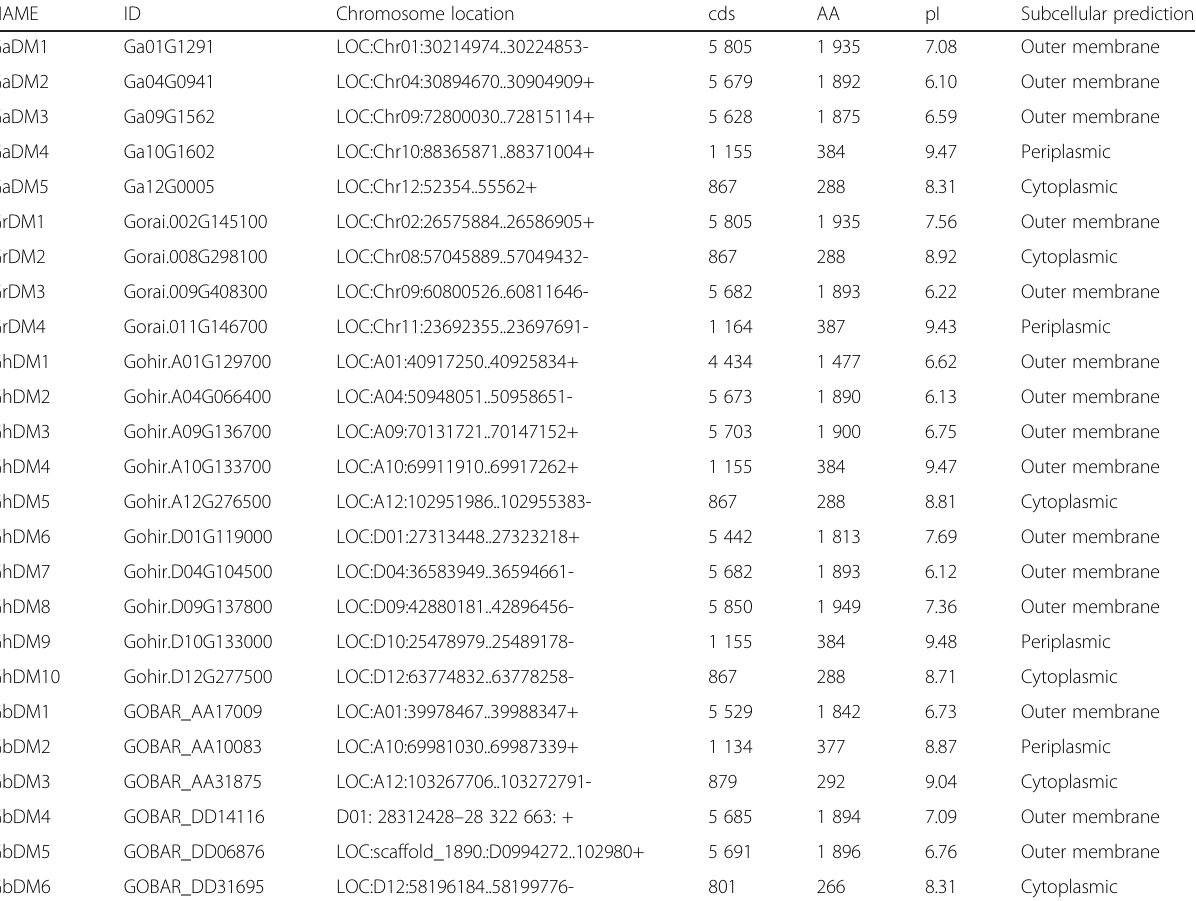
Table 1 Basic characteristic of DNA MT genes in cotton